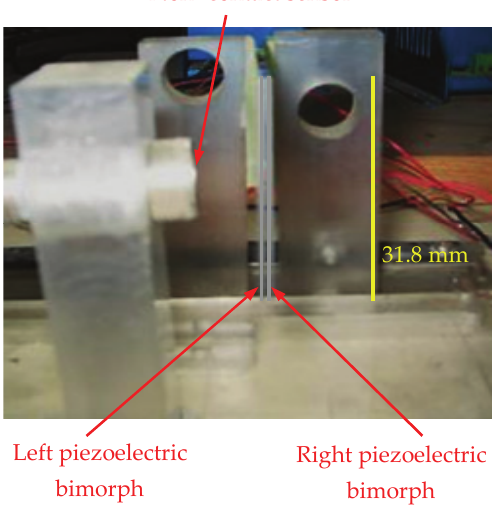
Figure 7. Two types of strain gauges (selected as a